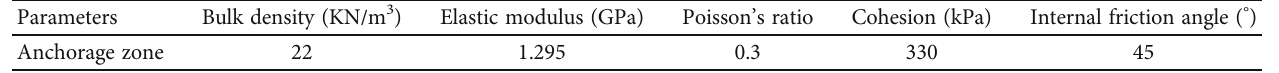
Table 2: Rock mass parameters of anchorage zone.